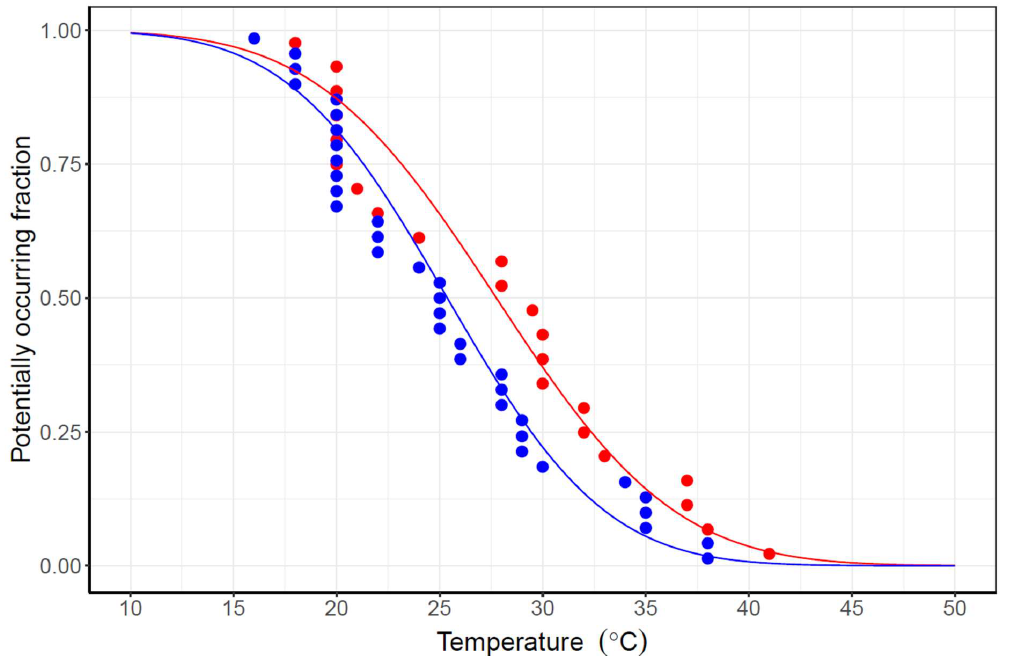
Figure 3. Species sensitivity distribution of maximum water temperature for native (blue; n = 35; µ = 25.4 °C; σ = 6.1 °C) and alien (red; n = 22; µ = 27.8 °C; σ = 7.0 °C) fish species occurring in the river Rhine (Data: Leuven et al. [10]). At 25 °C only 53% and 66% of the native and alien species pool can occur based on their thermal maxima, respectively.